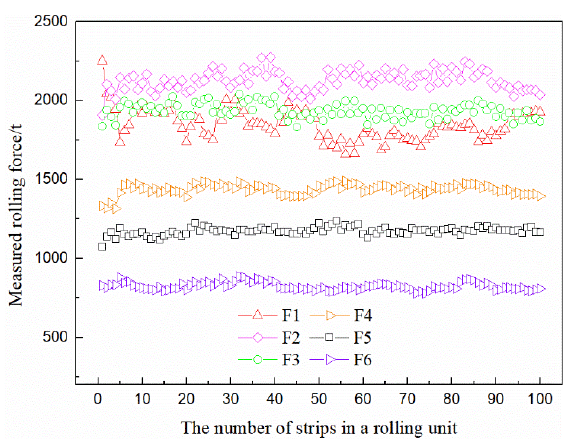
Figure 6. The measured rolling force of each stand.